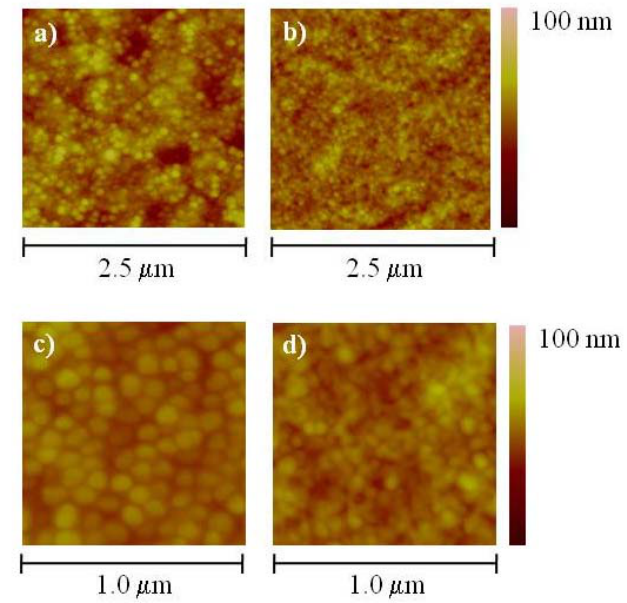
Figure 6. Atomic force microscopy (AFM) topographical images of poly(ethylene glycol) (PEG) derivatized (a and c) and a reference unmodified T4 nanoparticles on mica (b and d). The same nanoparticles concentration was used in both